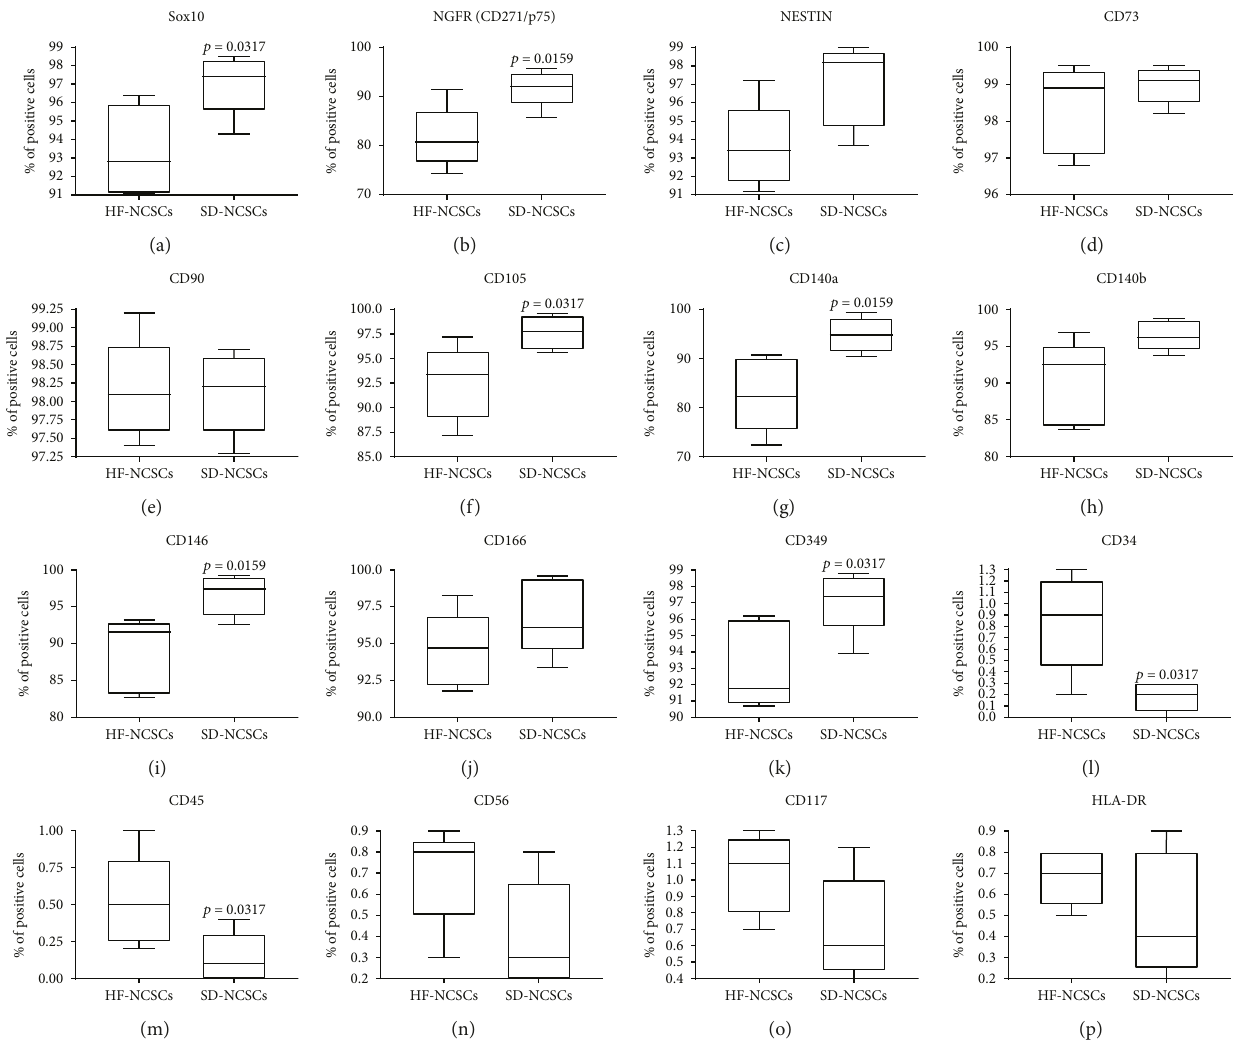
Figure 4: Immunophenotype analysis of NCSC cultures isolated from human hair follicles and skin dermis at P3. (a – p) Expression of characteristic NCSC markers by HF and SD NSCSs; mean ± SD for cultures from fi ve